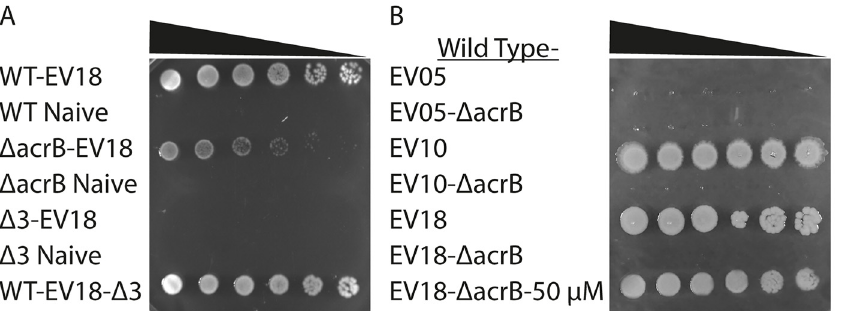
Fig 4. The role of the transporters in maintenance of high-level resistance. A. Solid phenotype in the presence of 400 μ M norfloxacin reveals a small but distinct difference in the resistance of Δ acrB -EV18 compared to WT-EV18. The suppliers are not required for maintenance of the high-level resistance of WT-EV18 to norfloxacin. B. Solid phenotype in the presence of 30 μ M norfloxacin. Nil strains of acrB generated after 5, 10 and 18 days of evolution revealed that it plays an important role in maintenance of high- level resistance at every stage. However, after a short exposure to high norfloxacin (50 μ M), resistance increases again. Nil strains were generated by deletion of acrB (WT-EV18- Δ acrB ) and of the three suppliers (WT-EV18- Δ 3) as described under Experimental